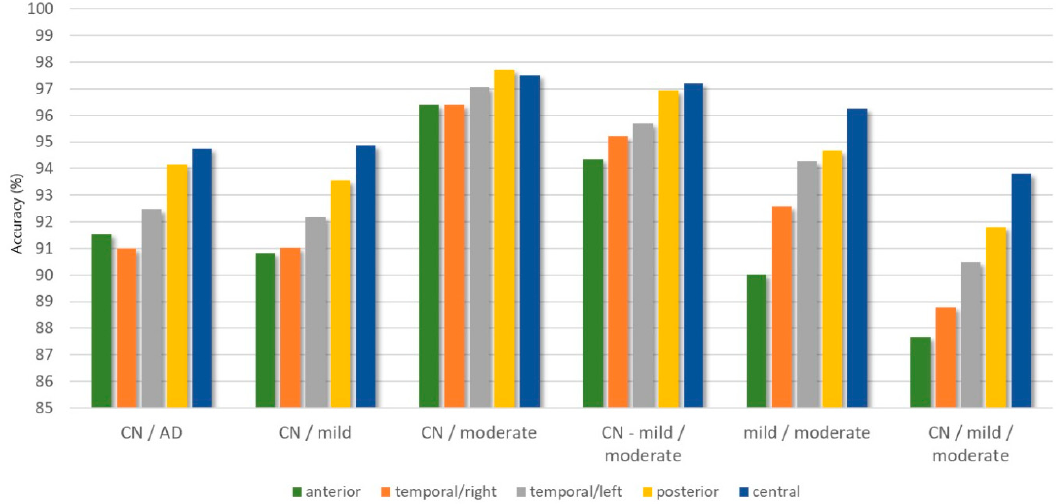
Figure 4. The distribution of the accuracy results in each cluster for the 5 classification problems: The abbreviation CN stands for Controls and AD stands for Alzheimer’s Disease.